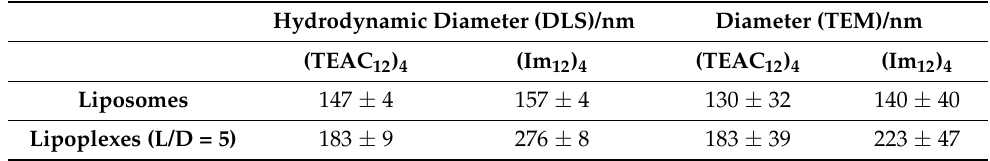
Figure 7. TEM images of the following systems: ( A ) (TEAC 12 ) 4 /DOPE liposomes with α = 0.3; ( B ) (Im 12 ) 4 /DOPE liposomes with α = 0.3; ( C ) (TEAC 12 ) 4 /DOPE/DNA lipoplexes with α = 0.3 and L/D = 5; ( D ) (Im 12 ) 4 /DOPE/DNA lipoplexes with α = 0.3 and L/D = 5. Table 3. Sizes of various liposomes and lipoplexes, with a molar ratio α = 0.3, measured by dynamic light scattering, DLS, and electronic transmission